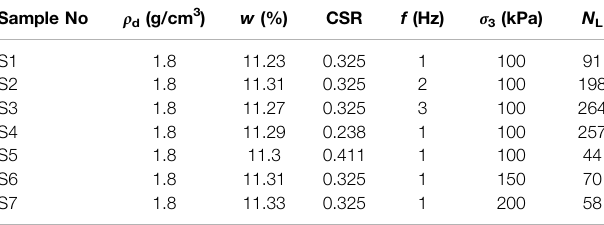
Frontiers in Earth Science |